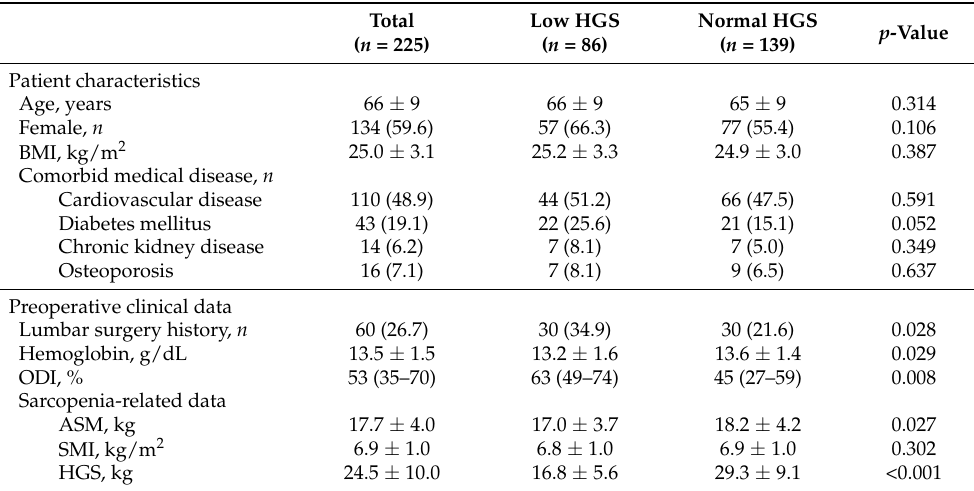
Table 1. Baseline characteristics of the study subjects.